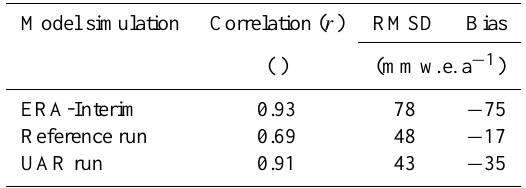
Table 1. Statistics of modelled SMB for Thwaites Glacier catch- ment, West Antarctica. The mean 1980–2009 SMB derived by snow radar is 457mmw . e . a − 1 .